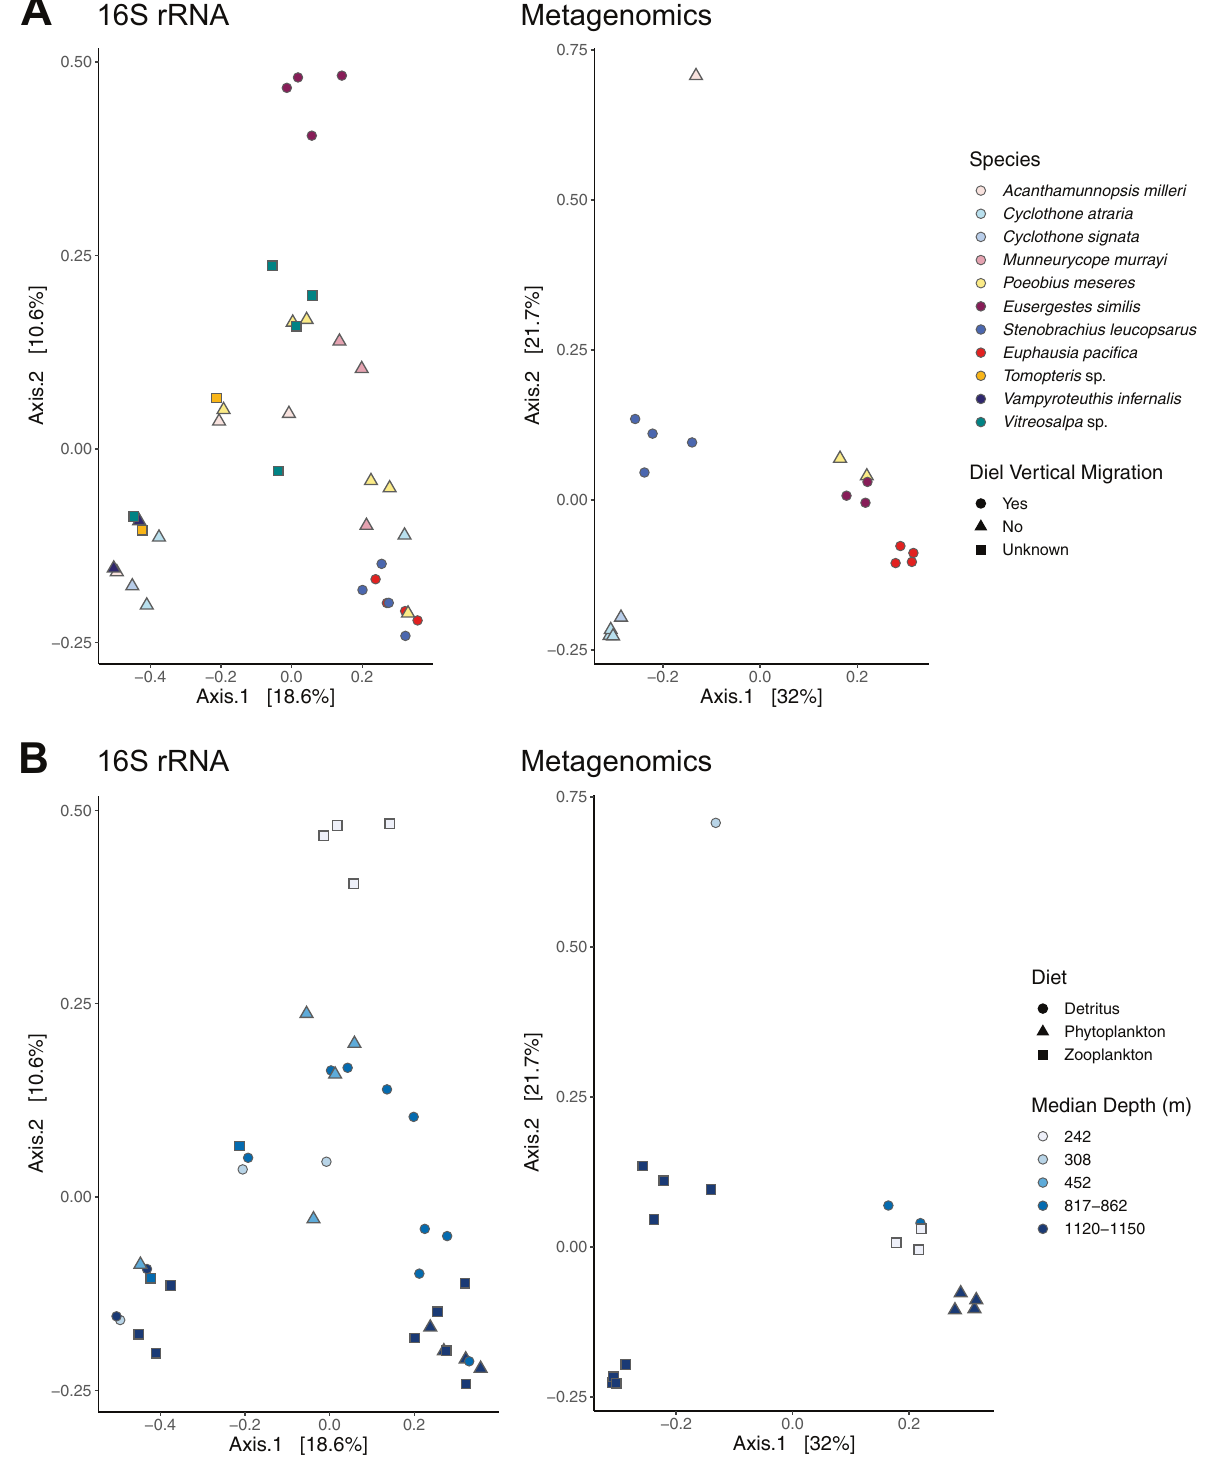
Fig. 2 Principal coordinate analysis plots for microbiome data transformed into Bray – Curtis dissimilarities. Panels A and B show the same data colored by host ( A ) and depth ( B ), respectively, with shapes showing diel vertical migration status ( A ) and diet category ( B ). Microbial communities cluster broadly by depth and in some cases host taxon. Clustering was weaker for vertical migration status and not evident for diet, though the in fl uence of both factors was signi fi cant in PERMANOVA (Table